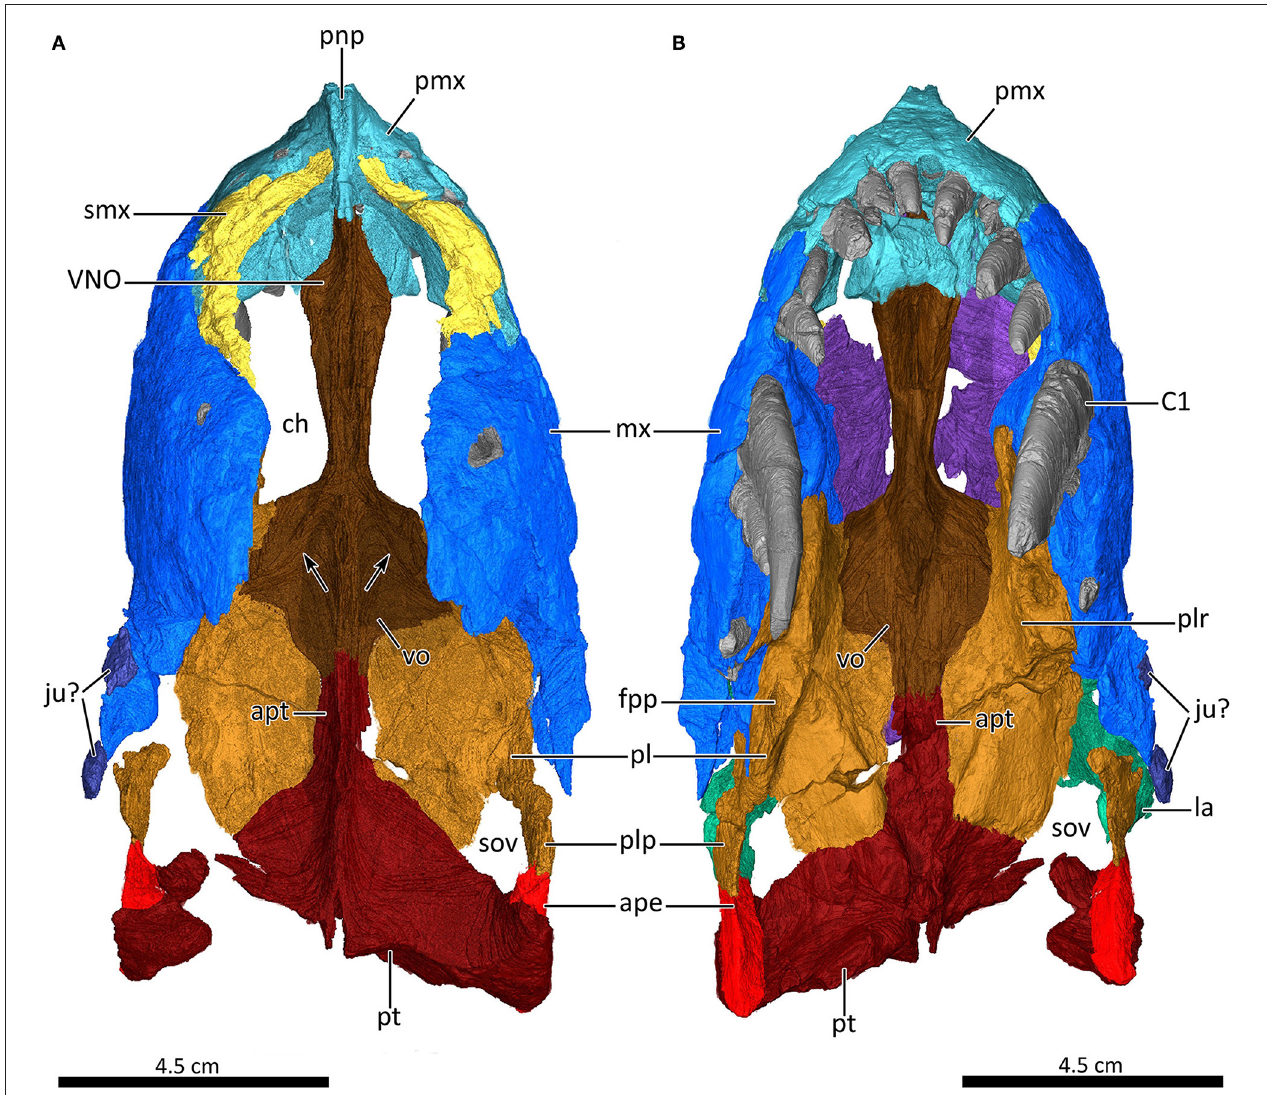
FIGURE 8 | 3D reconstruction of the snout of MB.R.995. (A) Snout in dorsal view with the nasals and lacrimals digitally removed to expose the internal structure. Arrows indicate the weakly-developed ridges on the posterior portion of the vomer. (B) Ventral view of the palate. ape, anterior process of the ectopterygoid; apt, anterior process of the pterygoid; C1, first canine; ch, choane; fpp, foramen palatine posterior; ju?, jugal?; la, lacrimal; mx, maxilla; pl, palatine; plp, posterolateral process of the palatine; plr, palatine ridge; pmx, premaxilla; pnp, prenasal process of the premaxilla; pt, pterygoid; smx, septomaxilla; sov, suborbital vacuity; VNO, channel housing the vomeronasal organ; vo,